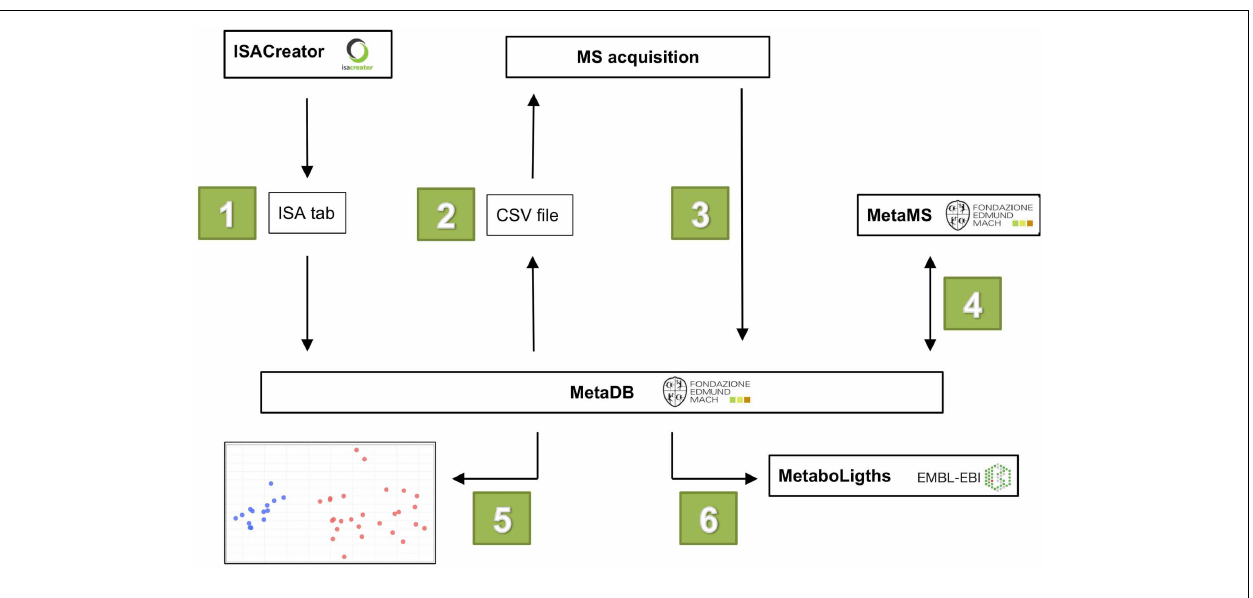
derived spectral data files are uploaded to MetaDB. (4) Data are processed using MetaMS. (5) Quality control of acquired data. (6) Data are prepared for storage and possibly for upload to public repositories such as